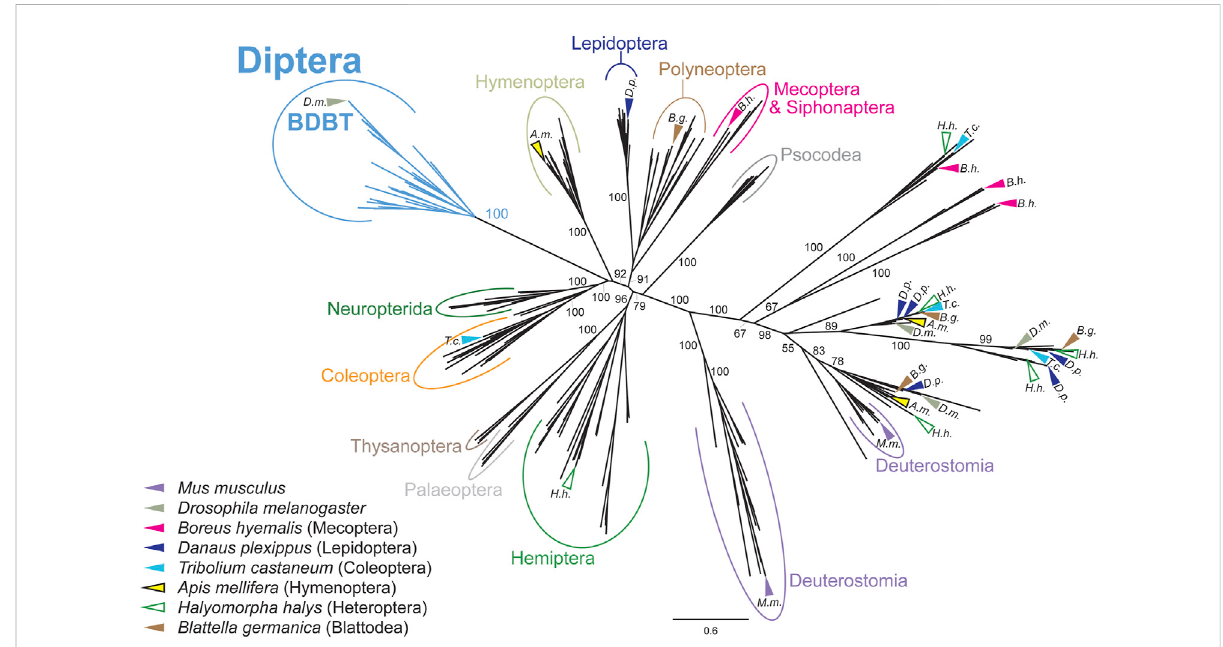
Phylogeny of FK506-binding proteins revealed a clear separation of dipteran BRIDE of DBT (BDBT) from all remaining clusters. Major insect orders are highlighted. Arrows indicate the position of sequences from representative species. FK506-binding proteins from Mecoptera